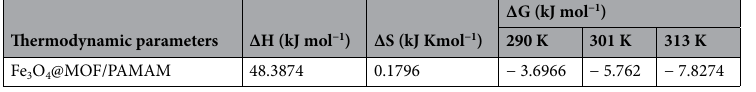
Table 6. Parameters of thermodynamic for MB adsorption.